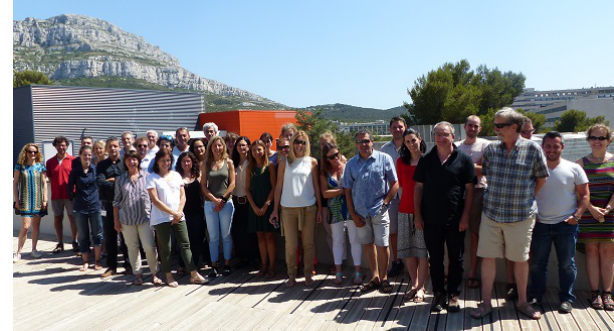
Figure 1. The OUTPACE team preparing the OUTPACE cruise.